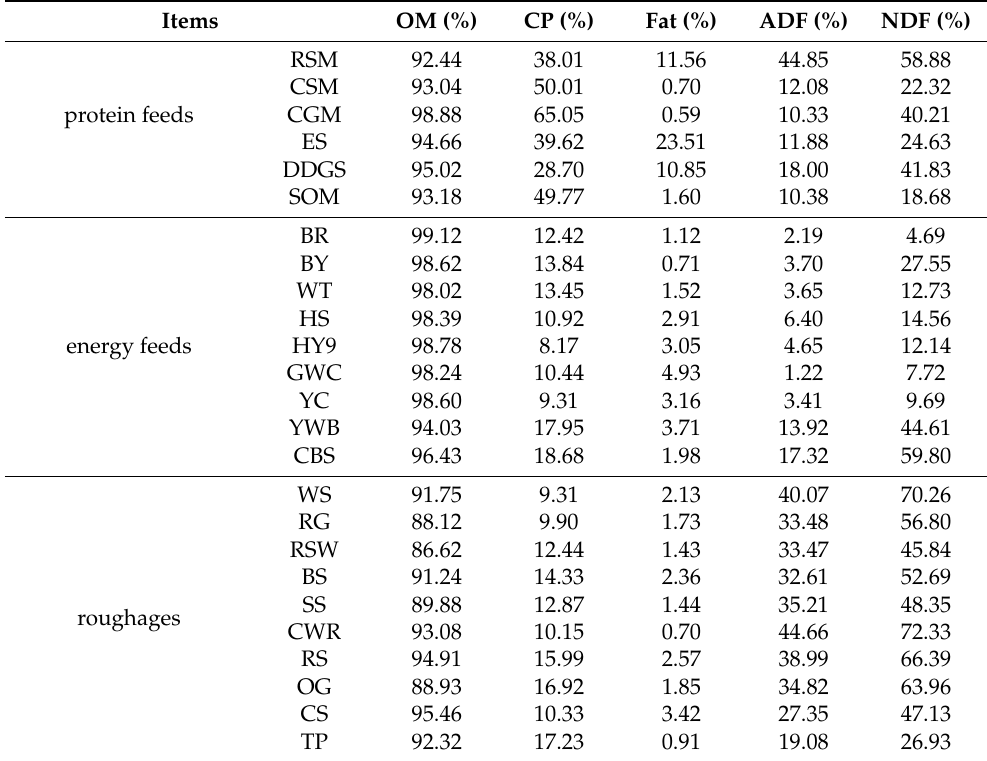
Table 2. Routine nutrients in common feeds for sheep (DM